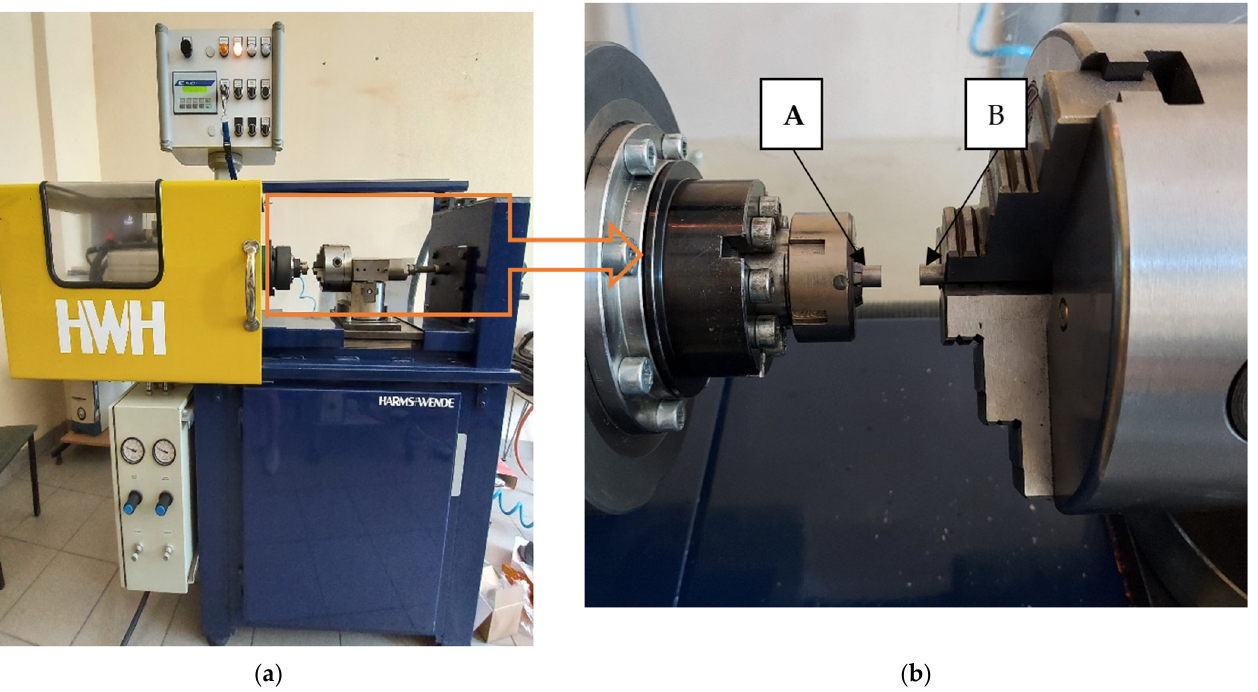
Figure 2. ( a ) High-speed rotary friction machine—general view, ( b ) fixing of specimens: A—rotating sample, B—stationary sample. sample, B—stationary